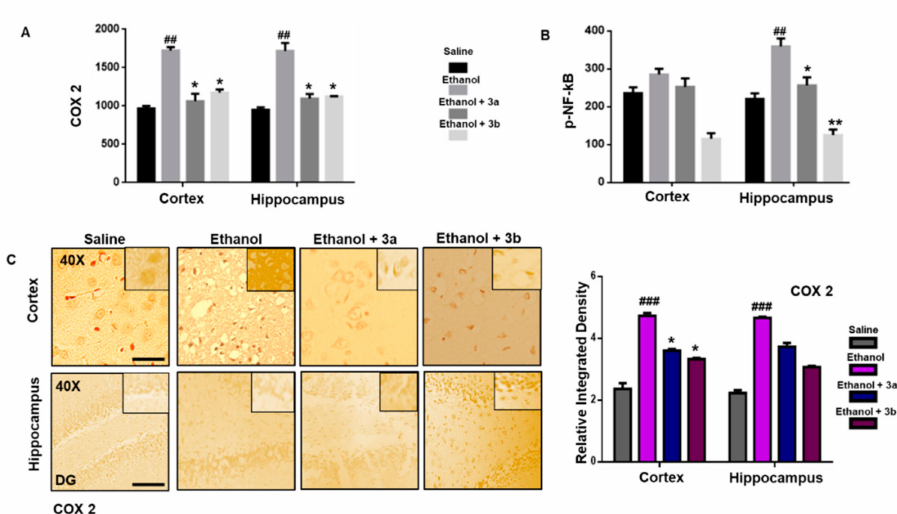
Figure 6. ( A , B ) The protein expression of COX2 and p-NF- κ B were quantified by ELISA. The data are expressed as the mean ± SEM. * and ** show p < 0.05 and p < 0.01, respectively, relative to ethanol, while ## p < 0.01 relative to saline ( n = 6 / group). ( C ) Immunohistochemistry results of COX2 in the cortex and Dg region of the hippocampus. Bar 20 µ m, magnification 40 × ( n = 6 / group). COX2 exhibited cytoplasmic localization in both tissues. Histograms show a comparatively higher expression of COX2 in the ethanol group. * shows p < 0.05 and indicates significant di ff erence relative to ethanol, while ### p < 0.001 shows significant di ff erence relative to saline group. Data are presented as mean ± SEM. Data are analyzed by one-way ANOVA followed by post hoc Bonferroni multiple comparison test using GraphPad Prism 6